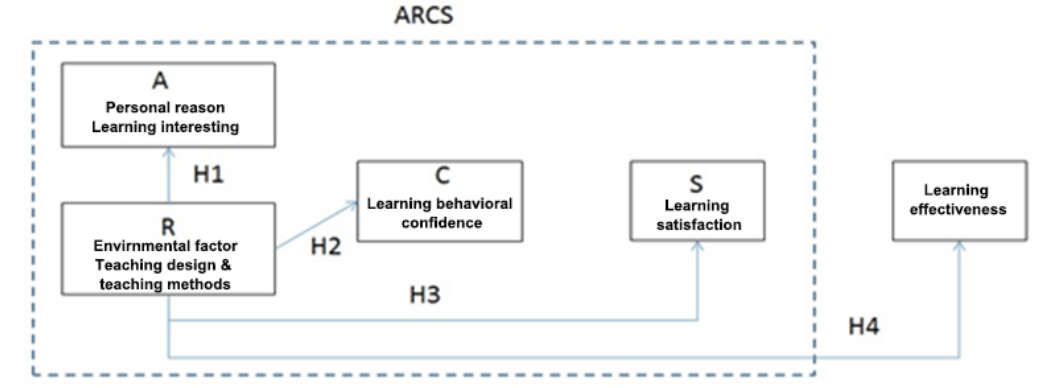
Figure 6. ARCS learning effectiveness statistical model, its parameters, and hypothesis.